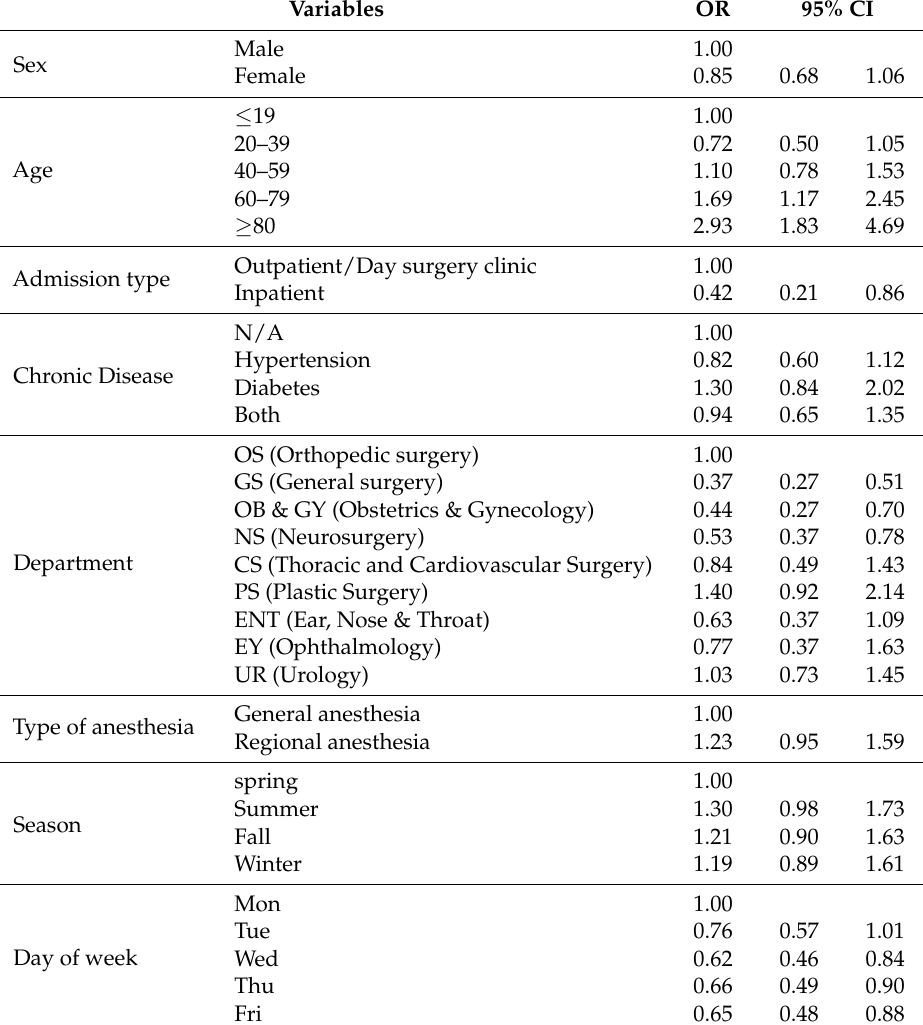
Table 5. Multivariable regression of the association with surgery cancellation and related factors (Emergency